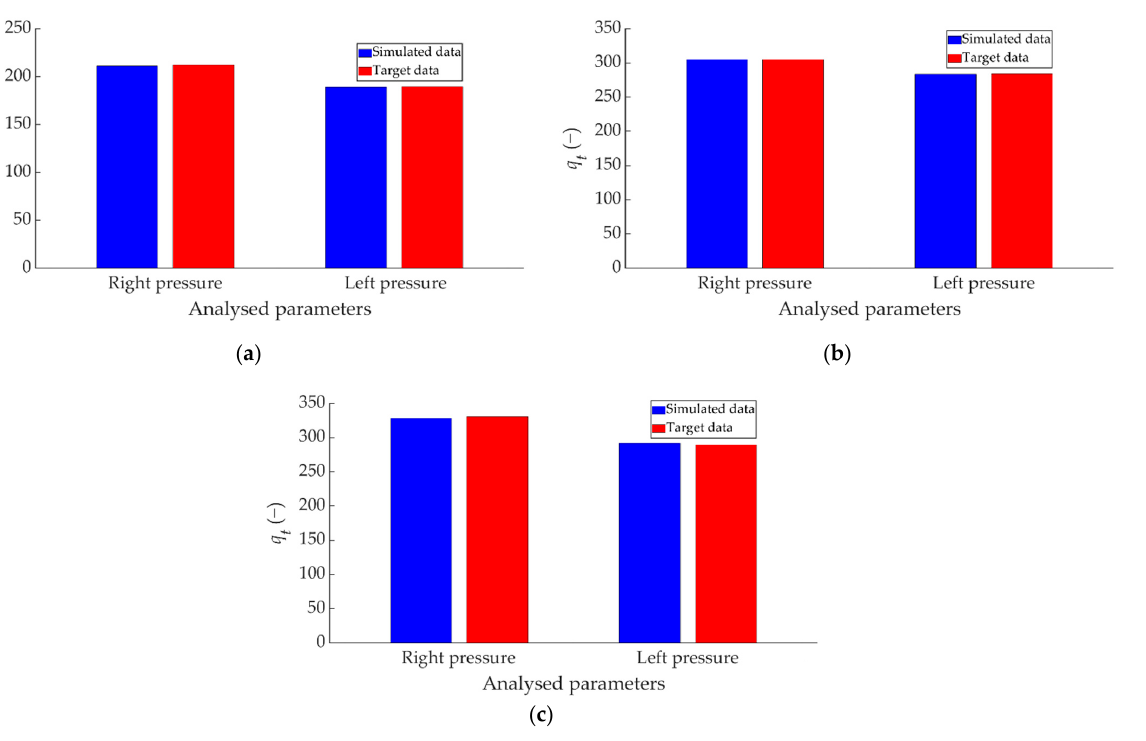
Figure 17. Comparison between ANN-simulated data and target q t data for the two pressure sensors for braking at a speed of 70 km/h for the type: ( a ) maintained, ( b ) progressive and ( c ) emergency. Figure 18 shows the comparison between the simulated data and the target data on how the braking capacity evolves as a function of braking time ( q v ) for the right pressure sensor over the 50 divisions performed.